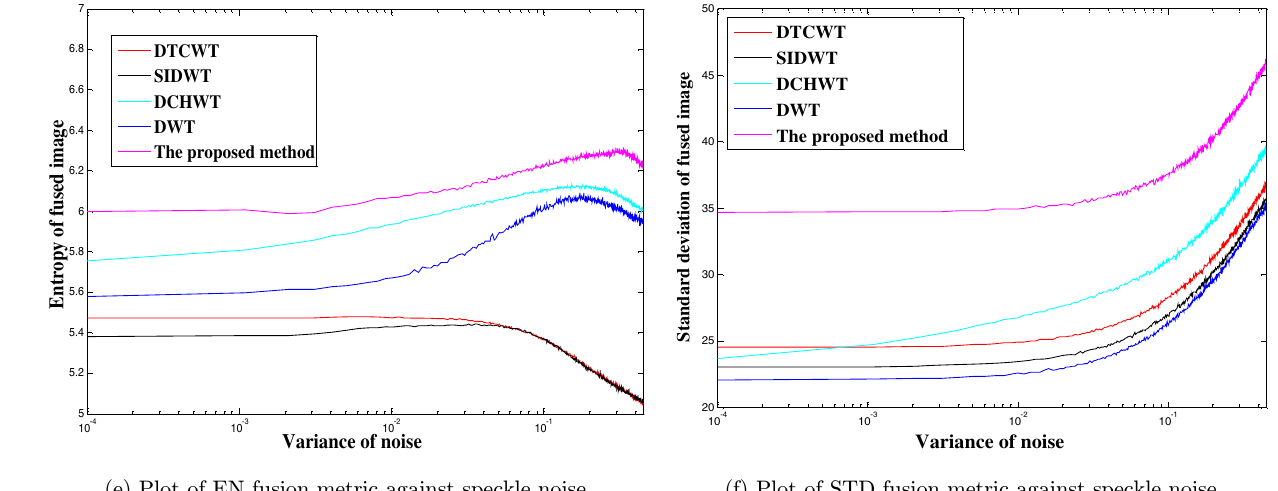
(f) Plot of STD fusion metric against speckle noise Fig. 7. Plots of EN and STD against di®erent types of